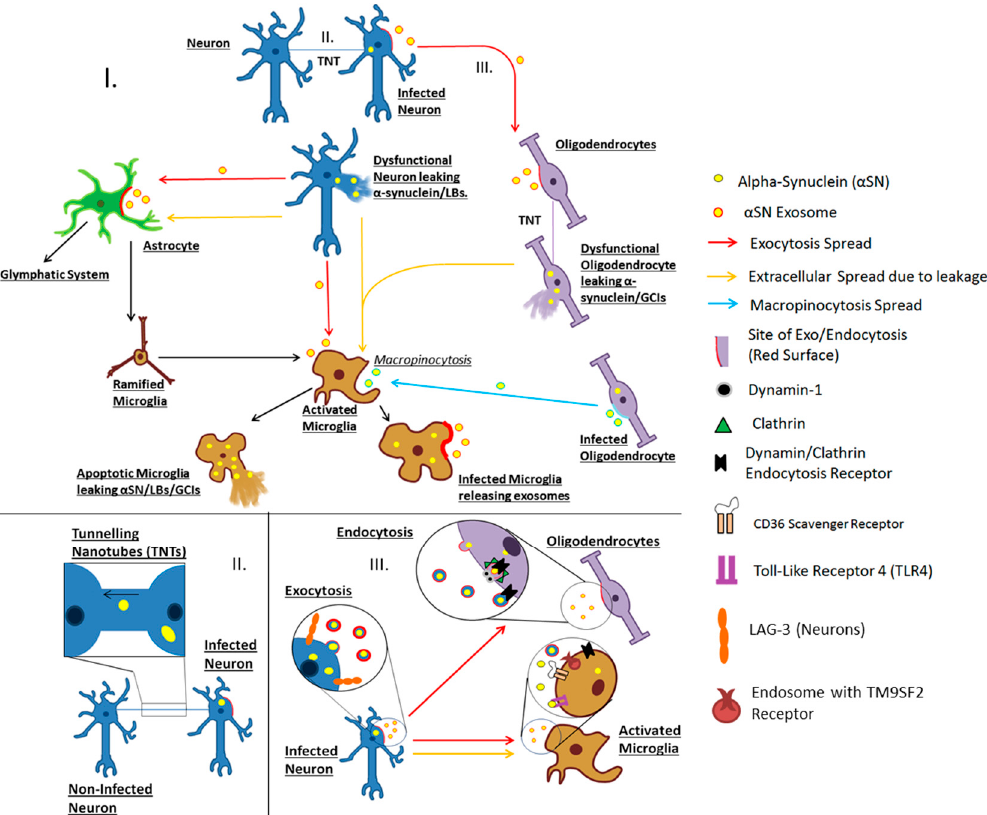
Figure 1. Hypothetical modes by which α -synuclein spreads in α -synucleinopathy disease. I . Release of α -synuclein/LBs via either exocytosis or membrane leakage due to apoptosis, necrosis or other damage. Astrocytes detect α -synuclein/LBs and signal for microglial recruitment by inflammatory factors. This also has the effect of activating microglia from the surveying ramified state to the phagocytic amoeboid phenotype ( black arrow ). Activation is also caused when ramified microglia detect α -synuclein either in exosomes or free in the extracellular matrix. Astrocytic activation can lead to dysregulation of glymphatic circulation via loss of aquaporin-4 polarization to endfeet, causing turbulent flow. Oligodendrocytes can take up α -synuclein-containing exosomes from neurons via endocytosis. Oligodendrocytes transfer α -syn to other oligodendrocytes either via exocytosis or tunneling-nanotubes (TNTs), eventually releasing α -synuclein through apoptosis/necrosis for phagocytosis by microglia. Oligodendrocytes may also release α -syn in exosomes. Microglia can engulf exosomes via macropinocytosis. Microglia perform phagocytosis on free and exosome-associated α -synuclein. Microglia may then mediate α -syn spread either via exosomes or via cell death or membrane leakage; II . F-actin TNTs exchange material between cells. In this illustration, an aggregate-bearing neuron ( right ) is transferring α -synuclein/LBs to an adjacent neuron ( left ) via a thick TNT causing spread of the pathological protein/inclusion body; and III . Transportation of α -synuclein via exo- and endocytosis. A neuron ( blue ), is undergoing exocytosis and the exosomes are travelling toward the oligodendrocyte ( purple ). Once close to the cell membrane of the oligodendrocyte, the exosomes may undergo different modes of endocytosis. One mode ( top ) involves fusing with the membrane of a target cell leading to the transfer of cargo. An alternate mode involves dynamin and clathrin mediated endocytosis, whereby the exosome binds to the receptor ( black ) which triggers its entry. Clathrin ( green triangles ) surrounds the budding vesicle whilst dynamin ( grey circles ) pinches the membrane off. The vesicle will then be fused with lysosomes for degradation. Microglia are shown activating clathrin/dynamin mediated endocytosis as well as microglial activation by CD36 scavenger receptor and Toll-like receptors (TLRs). Neurons have LAG3 and TM9SF2 receptors on the surface which when bound by fibrillar α -syn, mediate clathrin-dependent endocytosis.